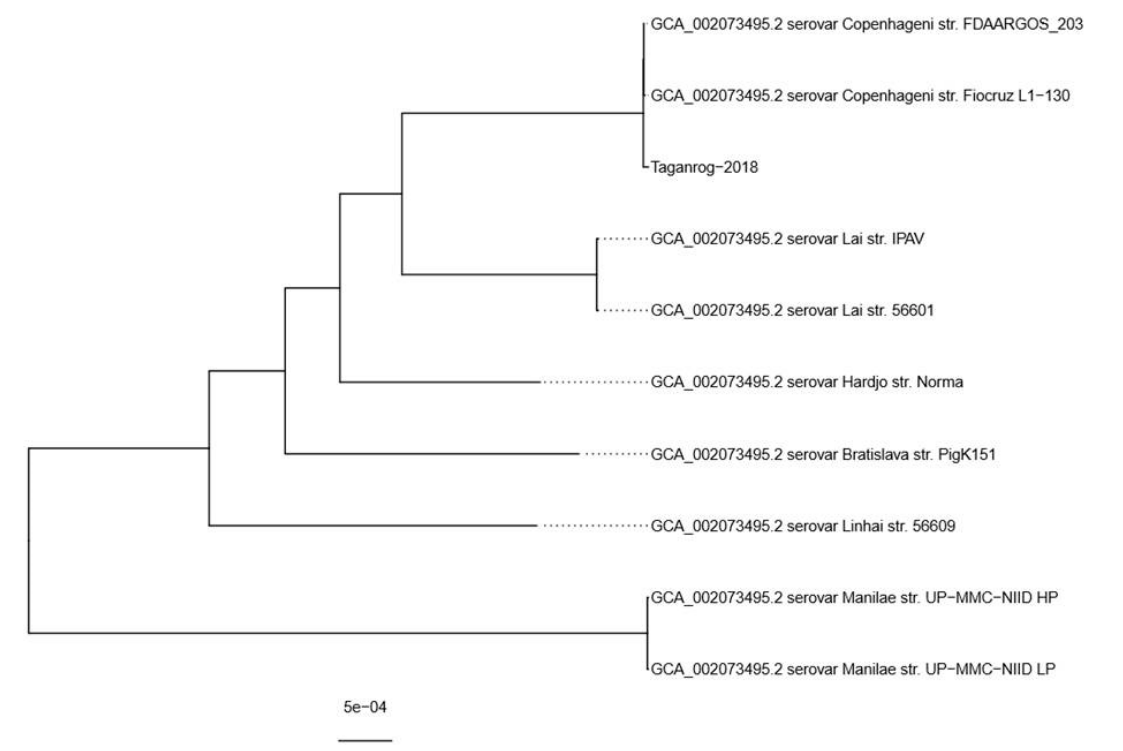
Figure 3. A midpoint-rooted phylogenetic tree of all available finished L. interrogans genomes and our assembly. Serovar and strain names are provided at the tip of labels.